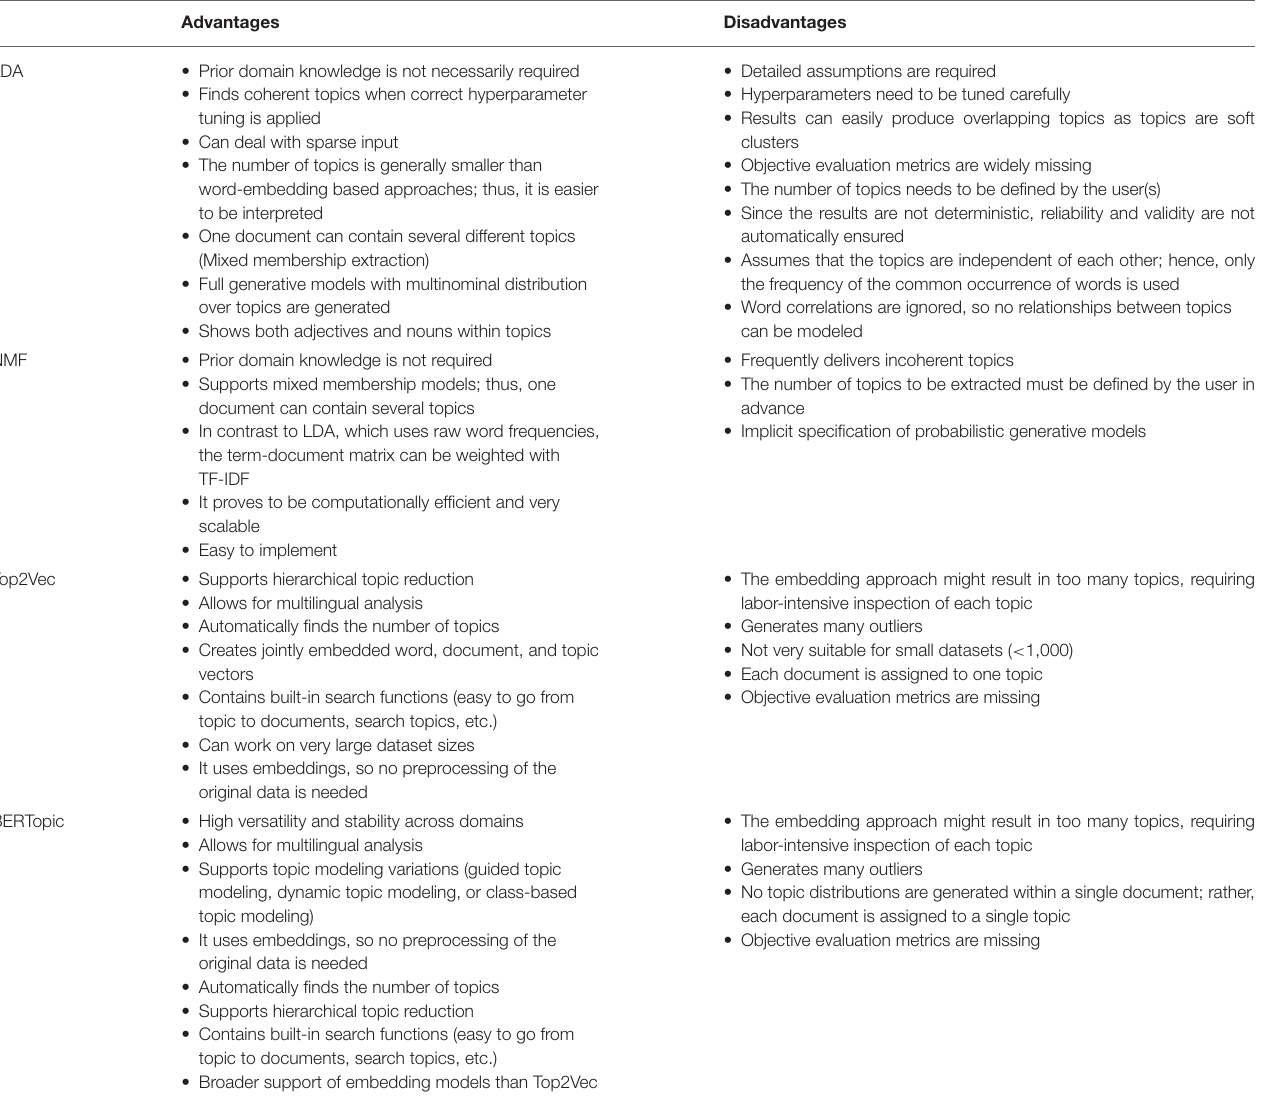
TABLE 5 | Comparison of topic